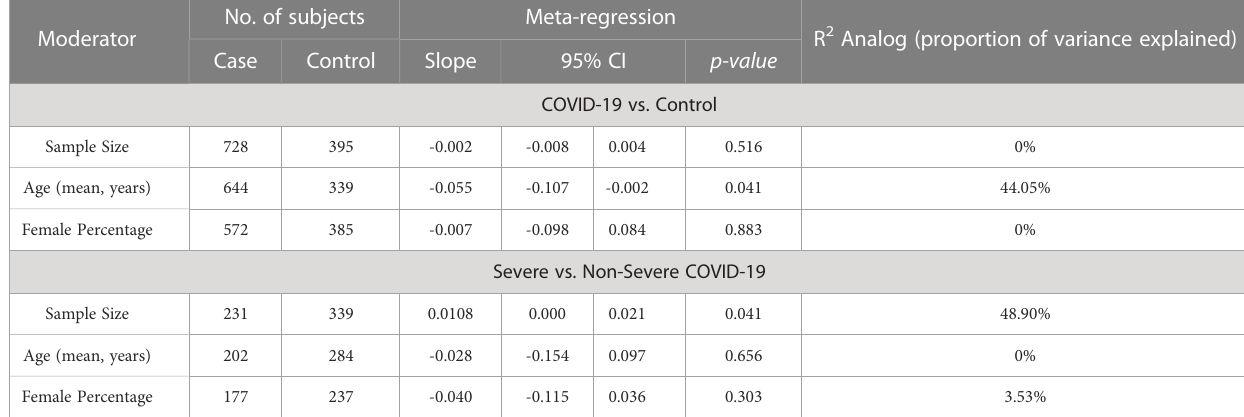
R 2 Analog (proportion of variance explained)